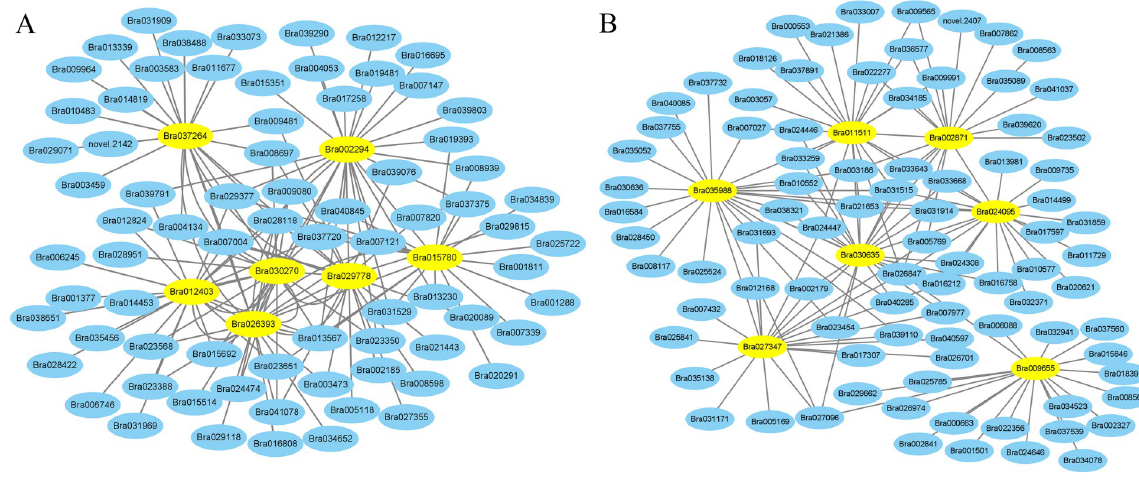
Fig 10. Analysis of hub gene co-expression network.